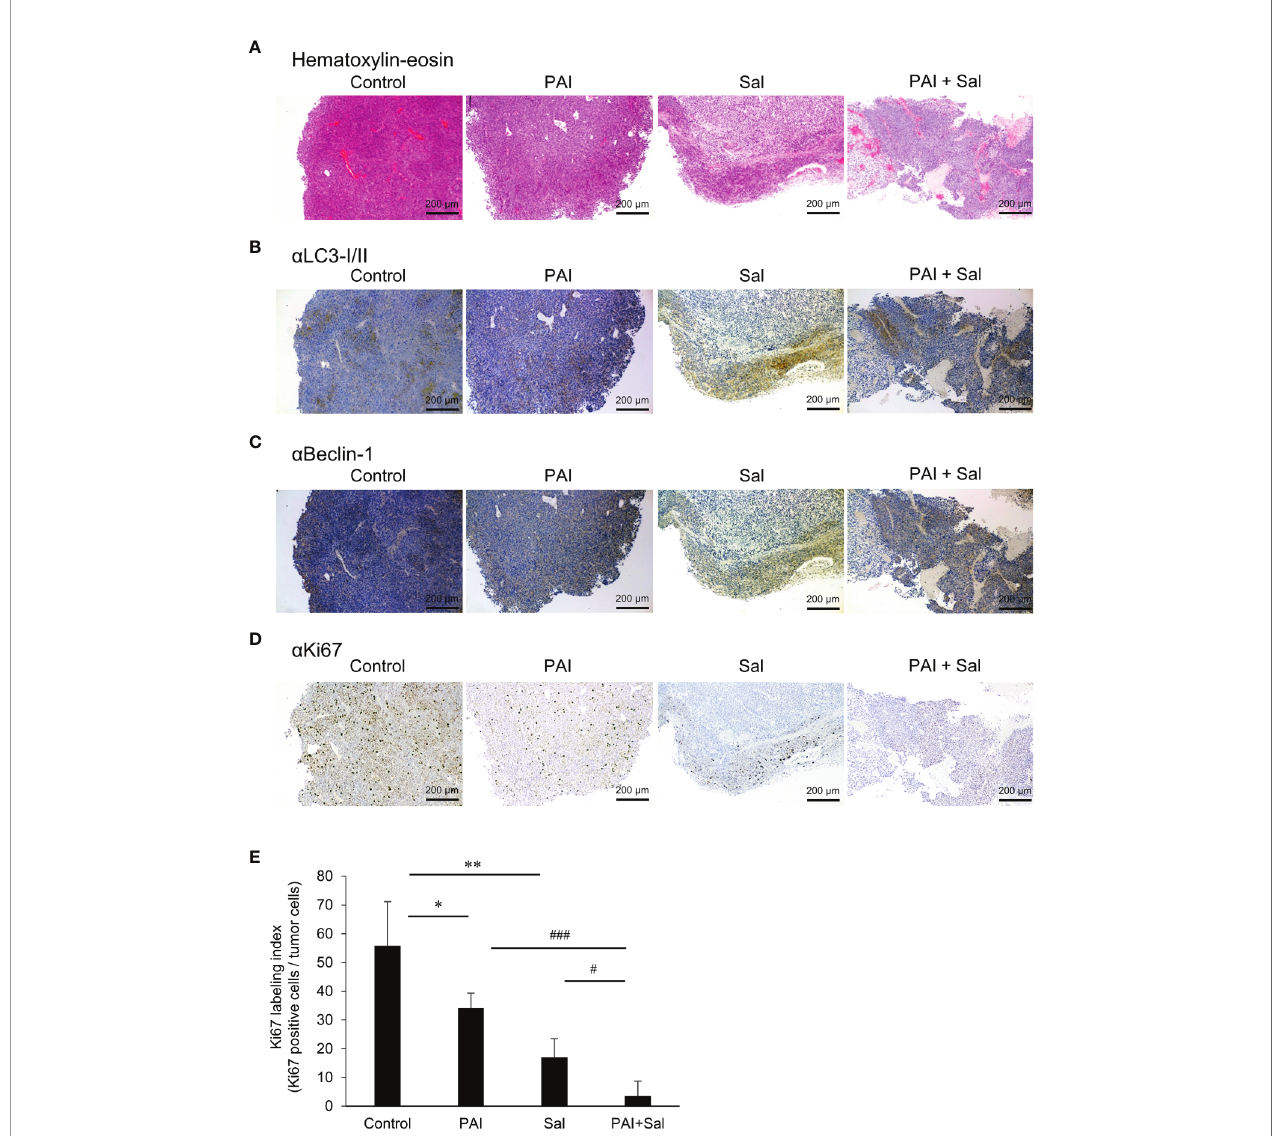
FIGURE 6 | Combined administration of PAI and Sal reduced the Ki67 labeling index. (A – E) Primary tumors were resected at day 35 after inoculation of LM8 cells. Hematoxylin-eosin staining (A) and IHC staining with primary Abs against LC3-I/II (B) , Beclin-1 (C) , and Ki67 (D) were performed. (E) Quantitative analysis of metastatic nodules in the lungs. Data were analyzed by one-way analysis of variance followed by Tukey ’ s post hoc test. Results are shown as mean ± SD. * P < 0.05; ** P < 0.01 compared with the corresponding control. # P < 0.05; ### P < 0.001 vs. PAI or Sal